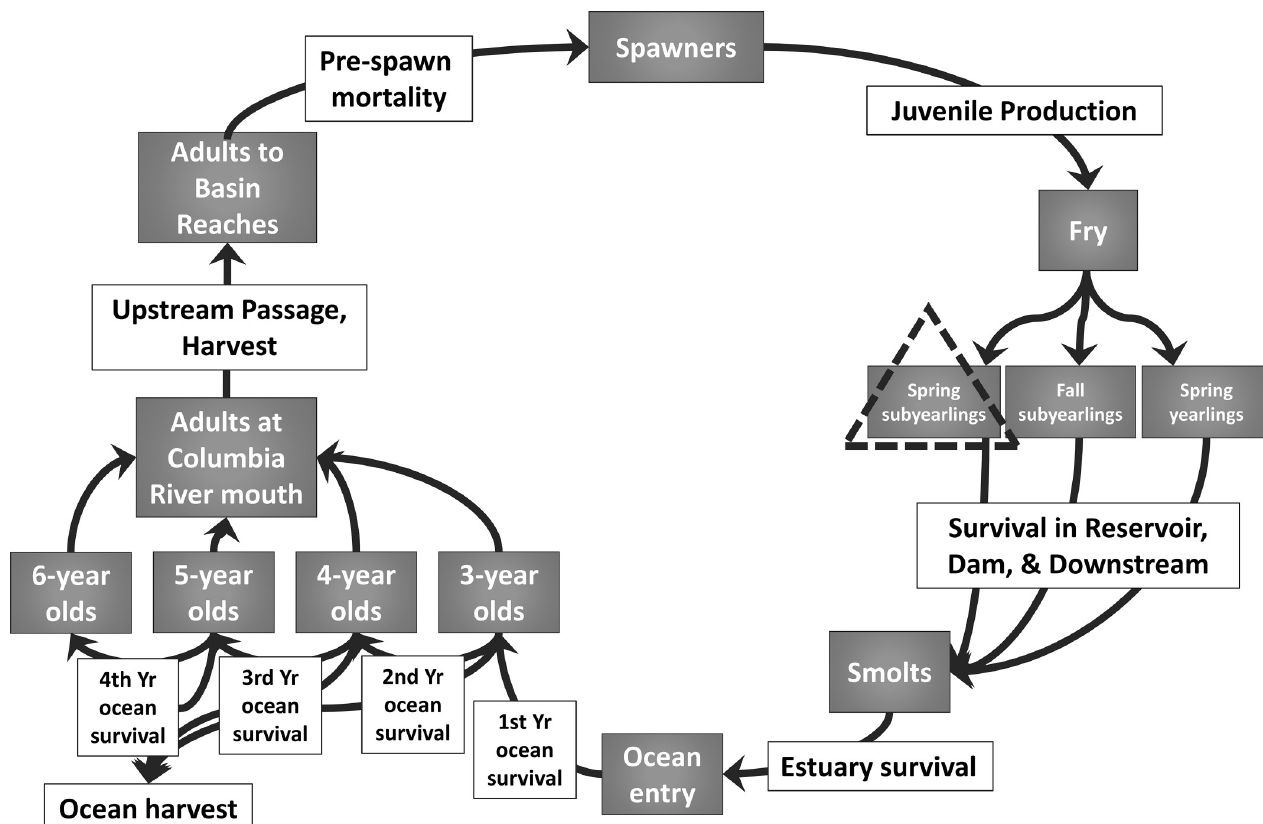
Fig 4. Simplified life cycle model of the McKenzie River Chinook salmon population (Upper Willamette River ESU) [18]. Gray boxes represent life stages and the white boxes describe transitions (representing survival or productivity) between life stages. The dashed triangle highlights the juvenile life-history pathway that is the focus of this